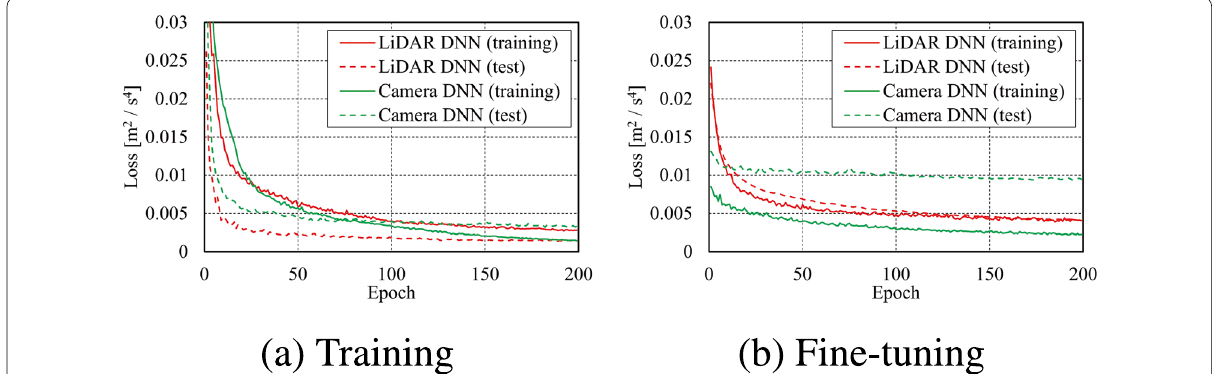
Fig. 7 Loss plotting. The DNNs converged the loss values by deep learning. The fine-tuning made the loss values on the real data